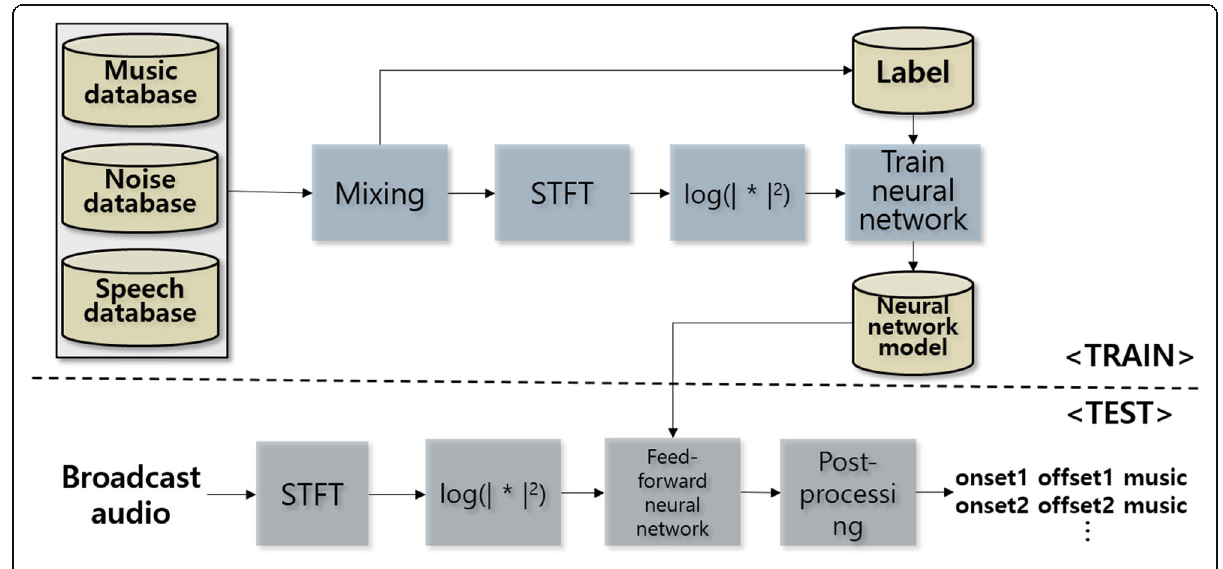
Fig. 1 Overall structure of the music detection system